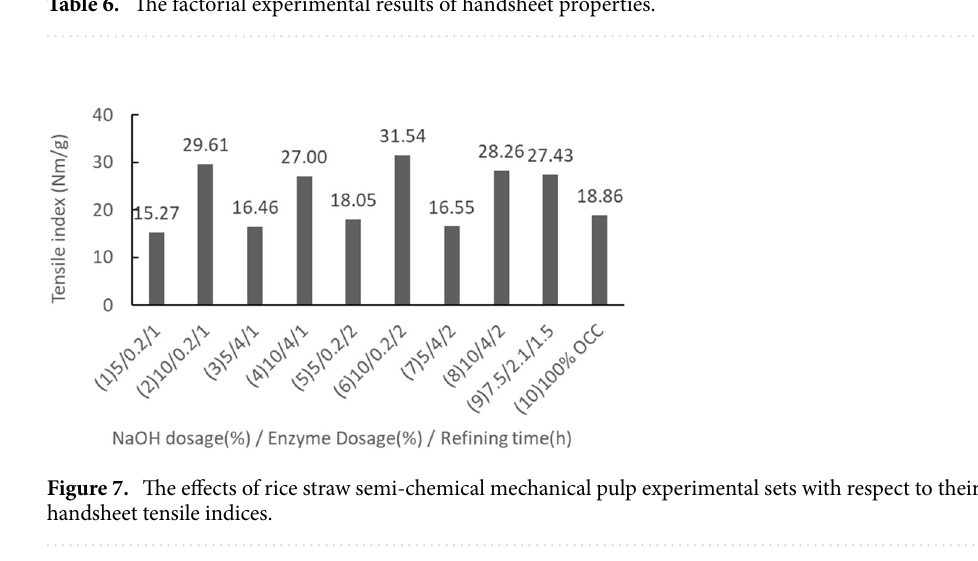
Table 6. The factorial experimental results of handsheet properties.